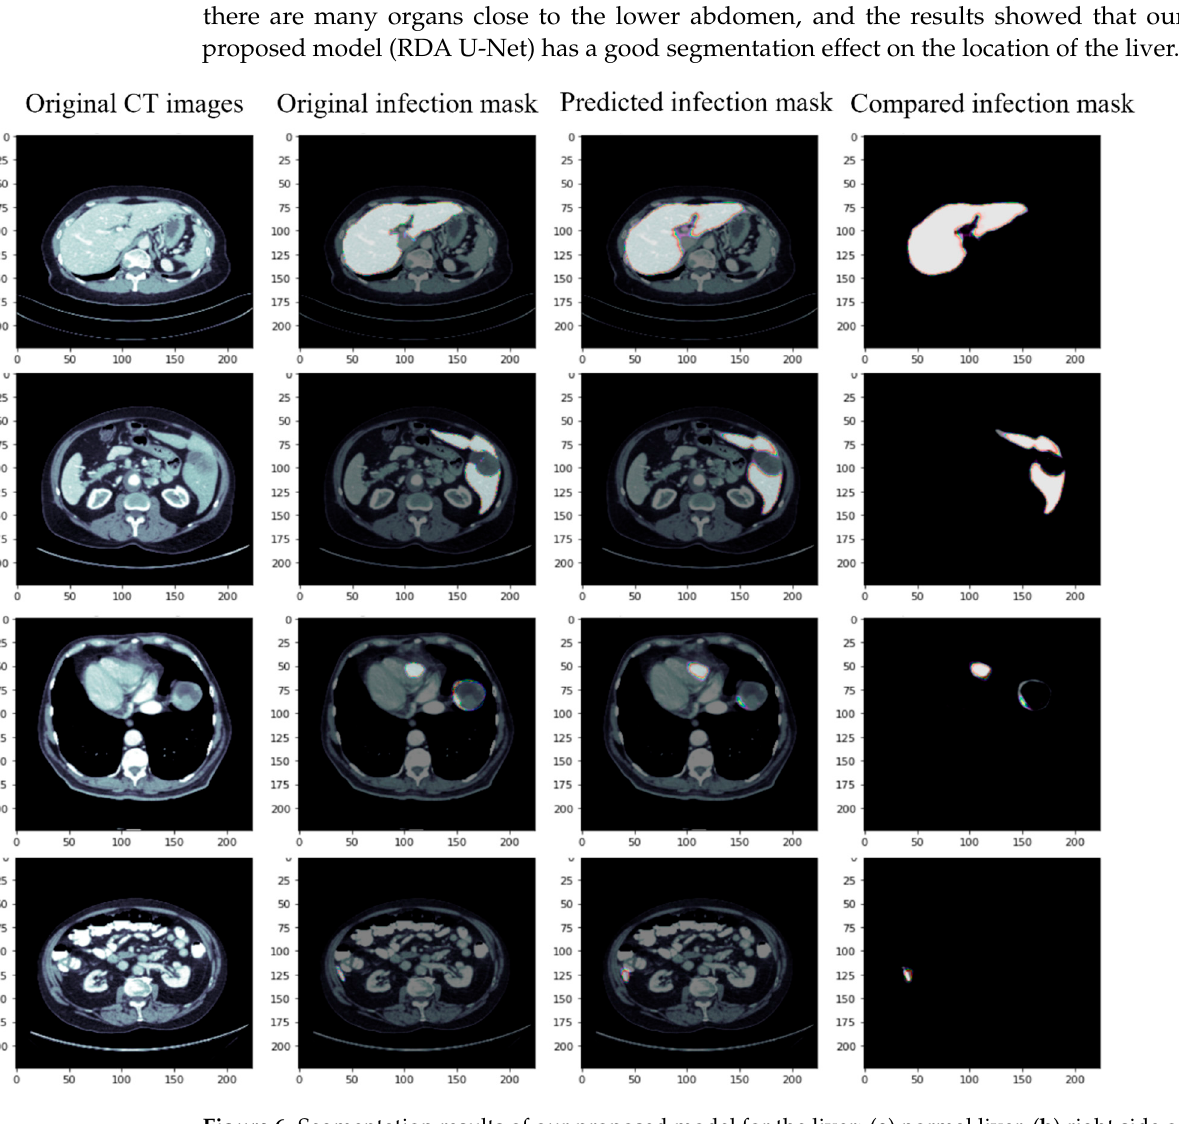
Figure 6. Segmentation results of our proposed model for the liver: ( a ) normal liver, ( b ) right side of the liver, ( c ) liver near the heart, and ( d ) liver near the lower abdomen (from left to right, original CT image, Ground Truth, predicted results of our proposed model, and superposition of Ground Truth and predicted results).